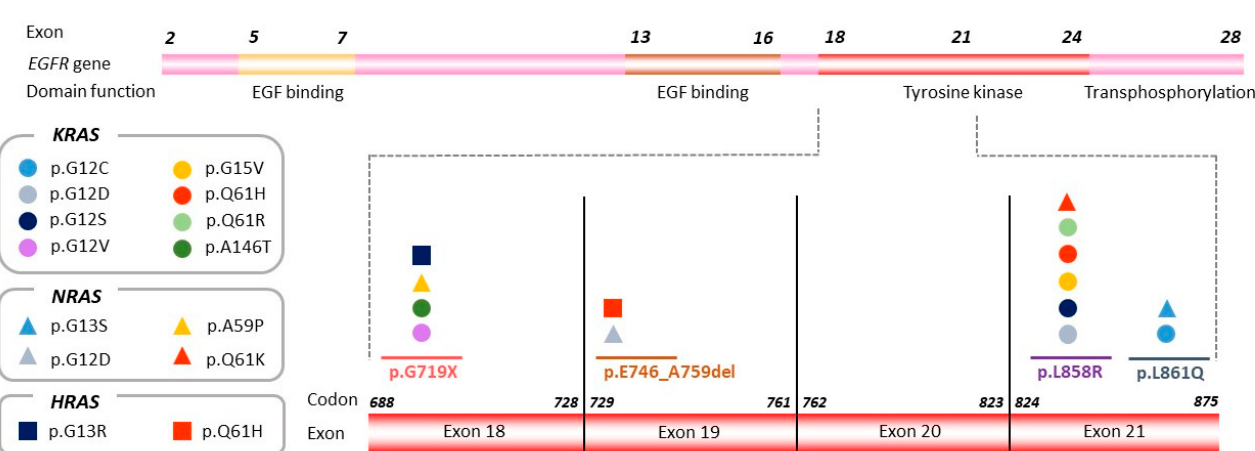
9 of 16 Figure 2. Swimmer plot of PFS and OS in CNV-positive patients. The PFS bar plot appears in dark color, whereas OS is represented continuing the same bar but in attenuated color. Disease progres- sion and exitus events are shown on bar plots as a vertical orange line and a black dot, respectively. CNV detection by NGS is represented with a yellow square. 3.3. Exon Location of the Original Sensitizing Mutation Determines Distinct Molecular Profiles upon Disease Progression Detection of the p.T790M mutation was more frequent in tumors harboring an EGFR mutation in exon 19 compared with tumors harboring an EGFR mutation in exon 21 ( p = 0.028). Among p.T790M-negative cases, two cases showed clinically actionable mutations